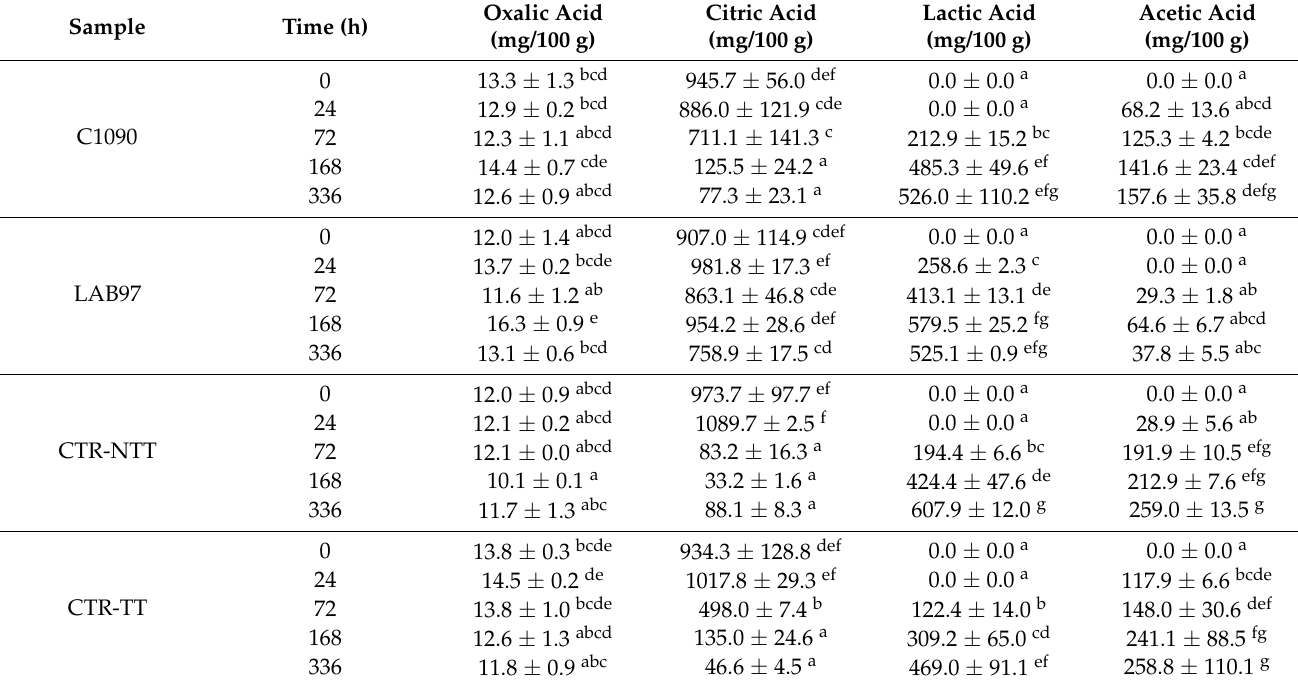
Table 1. The mean (and standard deviation) values of the organic acid contents (oxalic, citric, lactic, and acetic acids) for all samples (C1090, LAB97, CTR-NTT, and CTR-TT) throughout 14 days. For each column, the numbers followed by different letters are statistically different (Tukey HSD test, p =